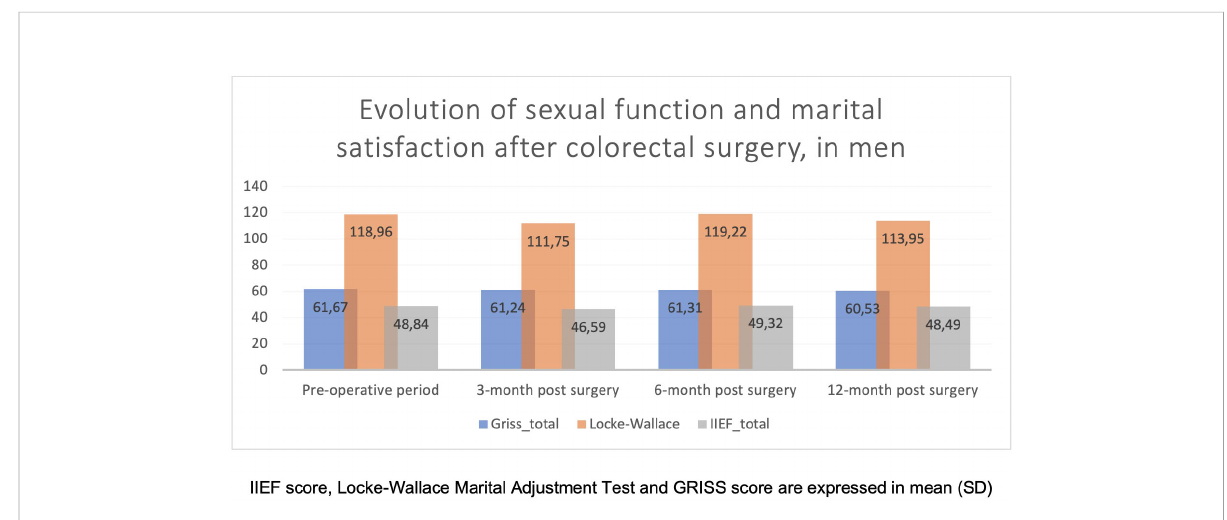
FIGURE 3 Evolution of sexual function and marital satisfaction after colorectal surgery, in